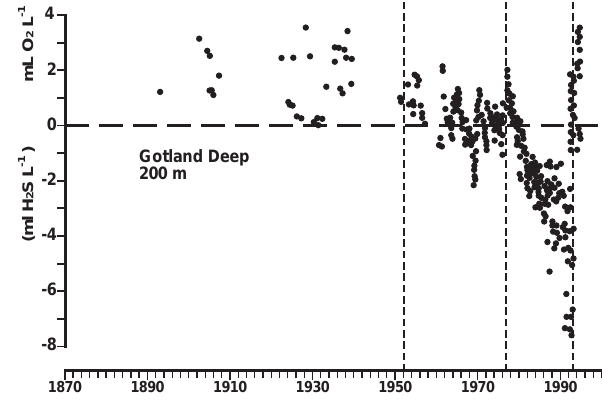
Fig. 5. Long-term variation in oxygen and hydrogen sulphide con- centrations in the Gotland Deep water during the last century. Hy- drogen sulphide is expressed as negative oxygen equivalents. (Ex- tracted and redrawn from Matth ¨ aus,